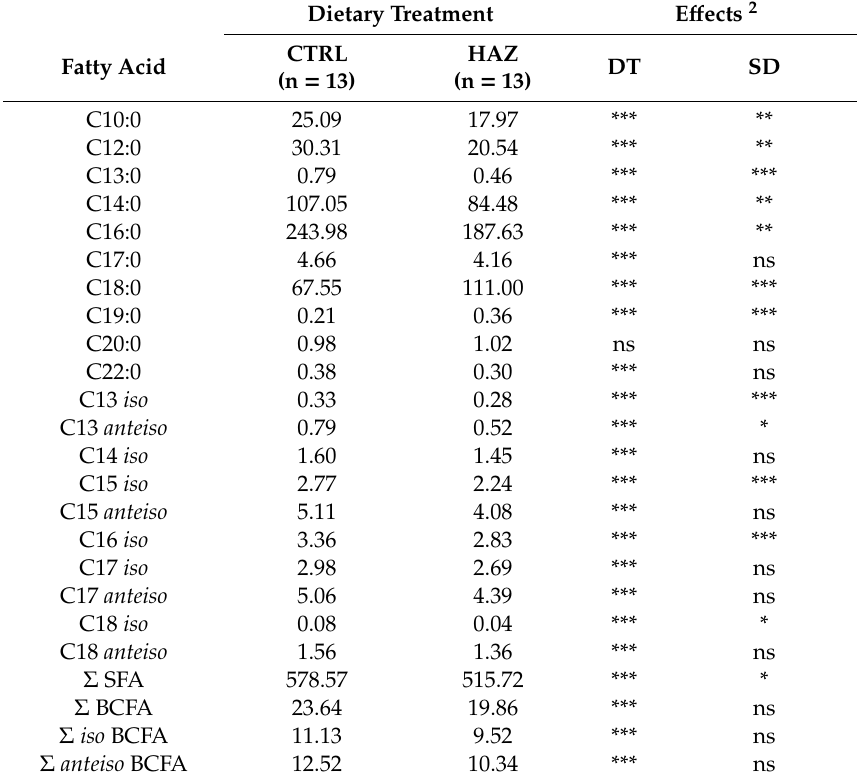
Table 4. Cont. Dietary Treatment E ff ects 2